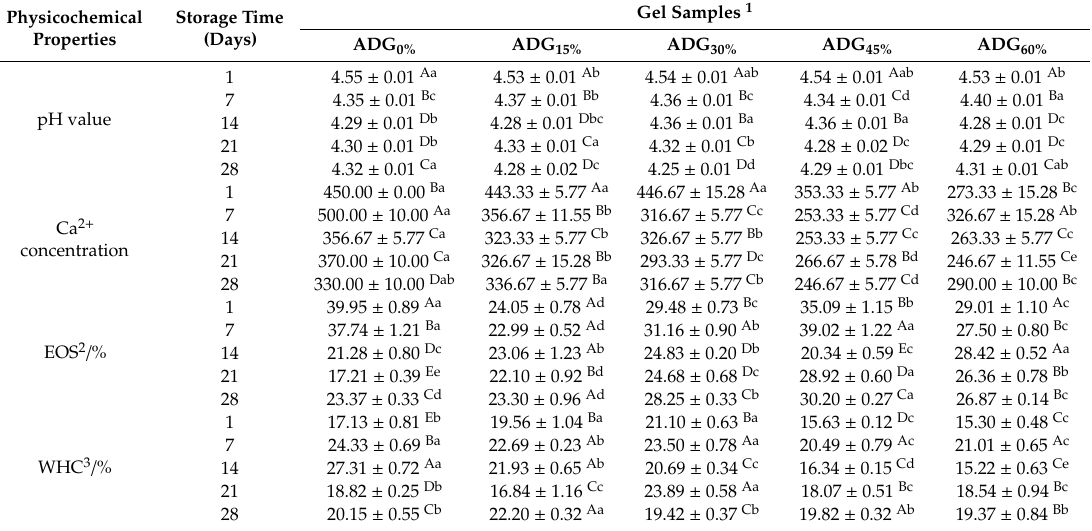
Table 1. Physicochemical characteristics between di ff erent formulations of black tea enriched acidified dairy gel (ADG) during a cold storage of 28 days (4 ◦